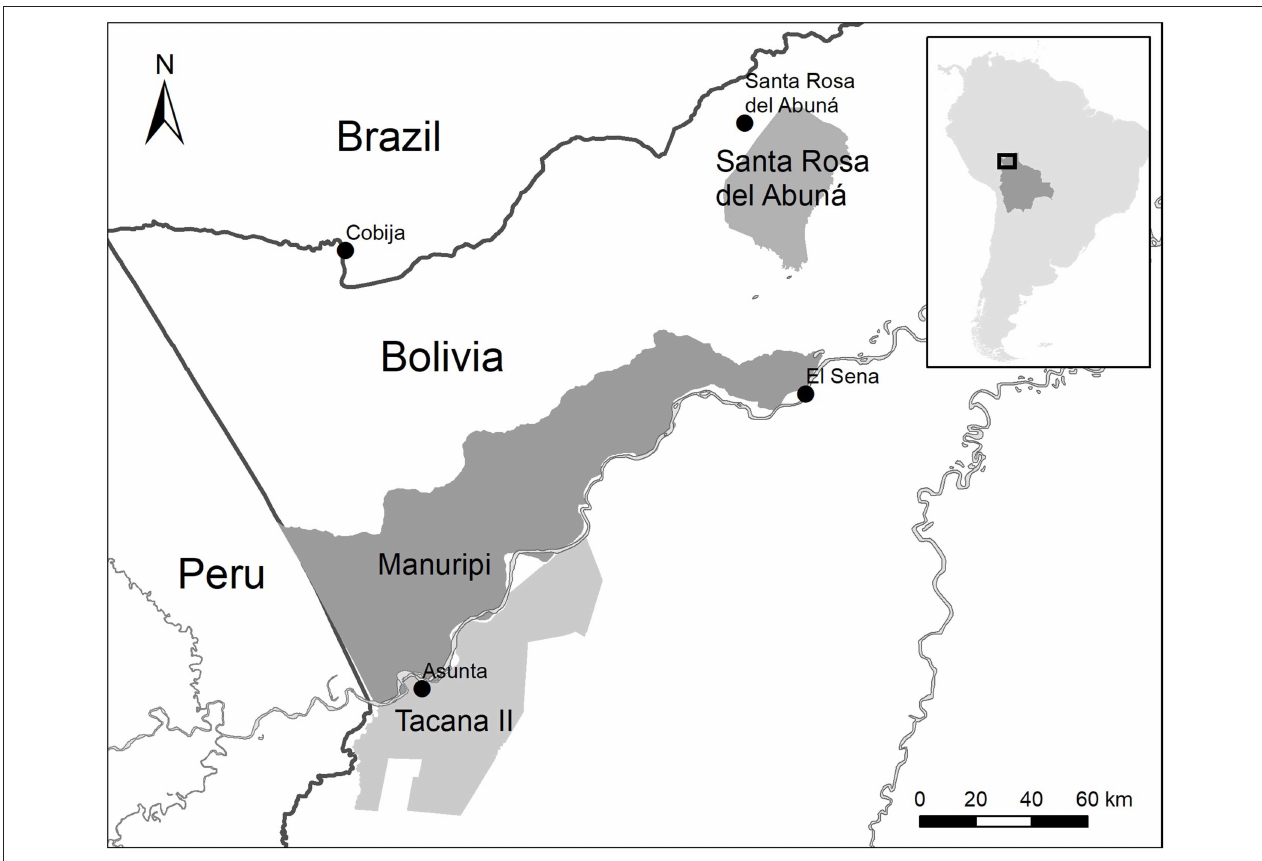
FIGURE 1 | Map of the study areas in Bolivia: Santa Rosa del Abuná (Santa Rosa), Tacana II, and Manuripi National Amazon Wildlife Reserve (MNAWR).